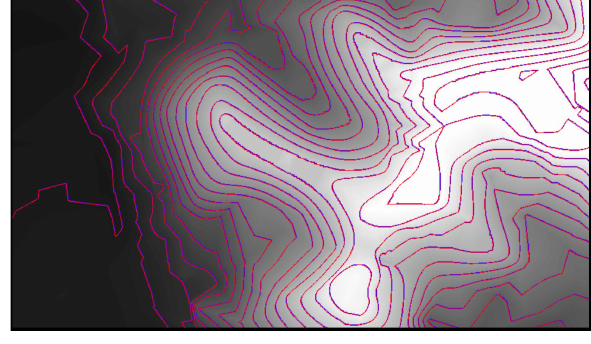
The other one is comparison between contours. The contours generated by result A DEM were compared with original contours. The Figure 6 is the illustration of the comparison between contours, red lines are original contours, and blue lines are contours generated by result B DEM. The maximum average distance between two lines is about 0.04 m.